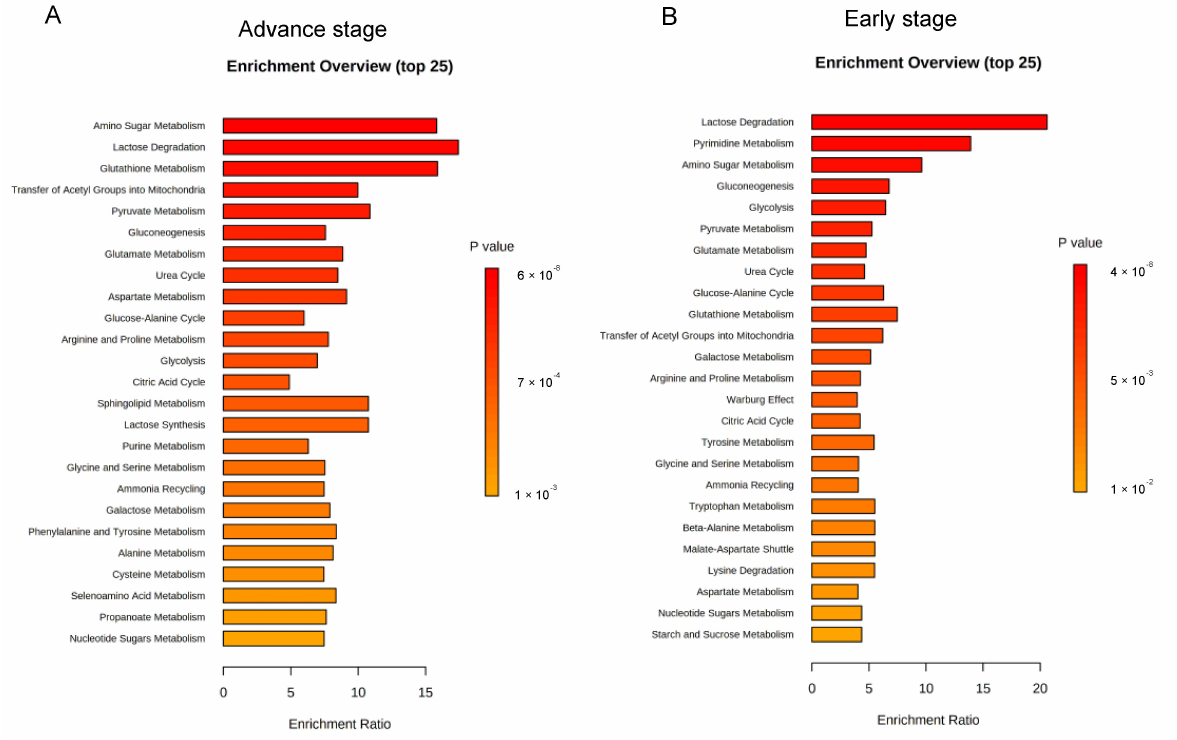
Figure 3. Enrichment analysis on metabolic pathways by folate-responsive and stage-sensitive tumour metabolomics markers. Enrichment analysis based on KEGG (Kyoto Encyclopaedia of Genes and Genomes) of the differential metabolites between suboptimal folate-NSCLC and paired lung tissues using MetaboAnalyst 5.0 (http://www.metaboanalyst.ca/, accessed on 21 December 2021). Enrichment metabolic pathways were analysed for the metabolomics signatures of low folate-tumours at ( A ) early stage and ( B ) advance stage. Median tumour folate was the cut out to stratify low and high folate-exposed NSCLCs. p ≤ 0.05 was used to select the significant enrichment. Bar length presents for enrichment ratio. Colour intensity of scale bar represents for log p